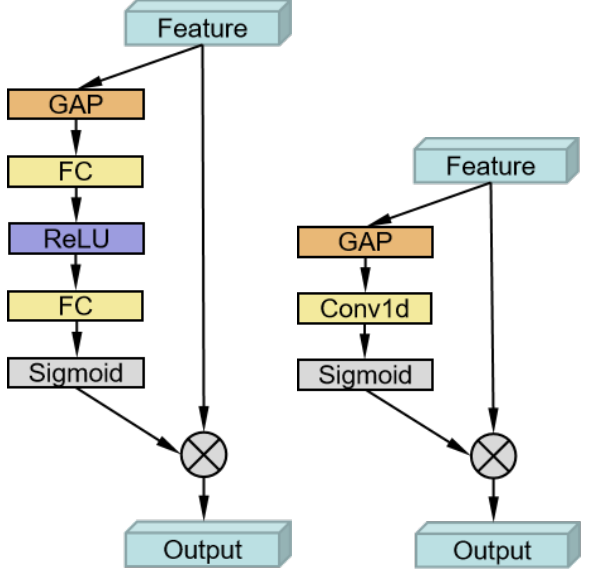
Figure 5. The left one is the SE block. The right one is the ECA